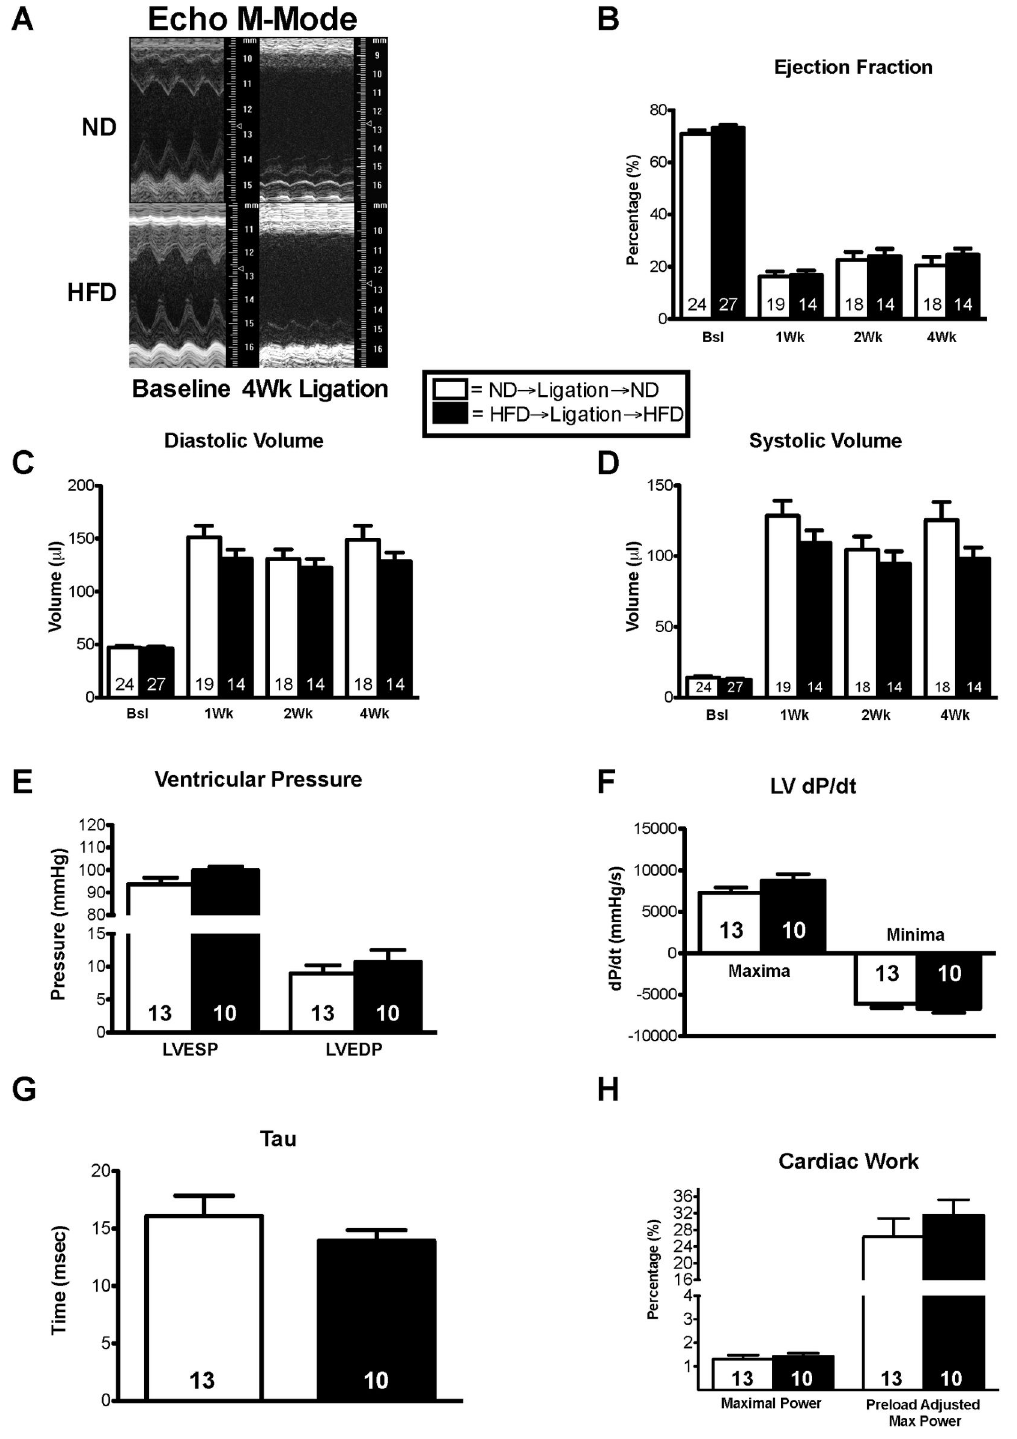
Figure 3. A high fat diet preceding and continued after infarction has no affect on cardiac function. ( A ) Long axis m-mode utilizing the Vevo 770 imaging system. ( B - D ) Ejection fraction, diastolic volume, and systolic volume were calculated using Simpson’s method. ( E ) Left Ventricular pressure was assessed via Millar catheter. ( F ) Cardiac contractility as accessed by the minimum and maximum rate of pressure change (dP/dt). ( G ) The rate of relaxation (Tau) and ( H ) the cardiac work remained unchanged between the groups. Results are expressed as means ± S.E., *, p< 0.05.